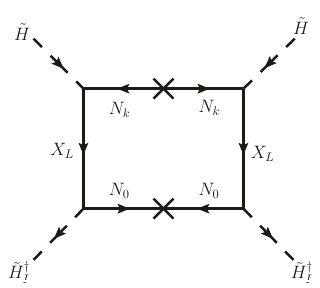
Figure 1 . Feynman diagram used to produce the λ 5 ( H † H I ) 2 term, where ˜ H †